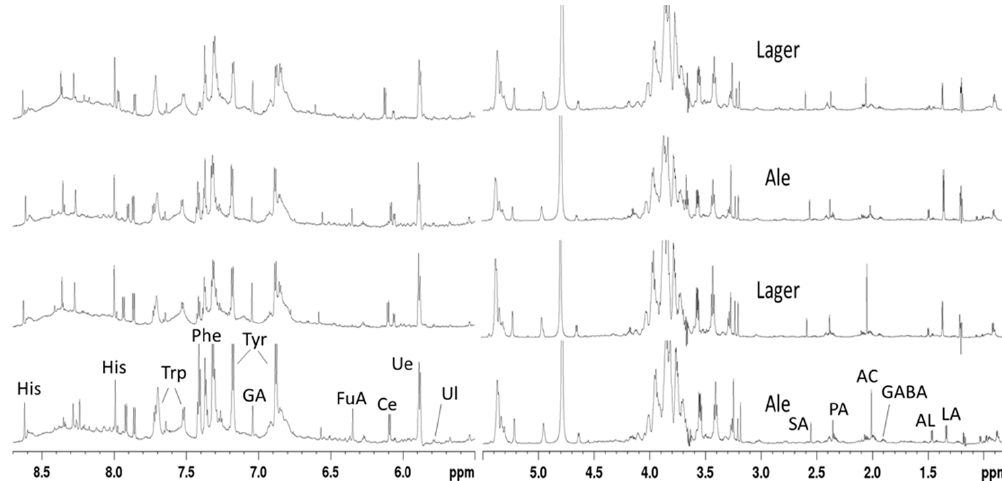
Figure 1. Representative 800 MHz 1 H NMR spectra of ale and lager craft beers in phosphate buffer solution. LA, lactic acid; Al, alanine; GABA, gamma aminobutyric acid; AC acetate; PA, pyruvic acid; SA, succinic acid; Ul, uracil; Ue, uridine; Ce, cytidine; FuA, fumaric acid; Tyr, tyrosine; GA, gallic acid; Phe, phenylalanine; Trp, tryptophan; His,